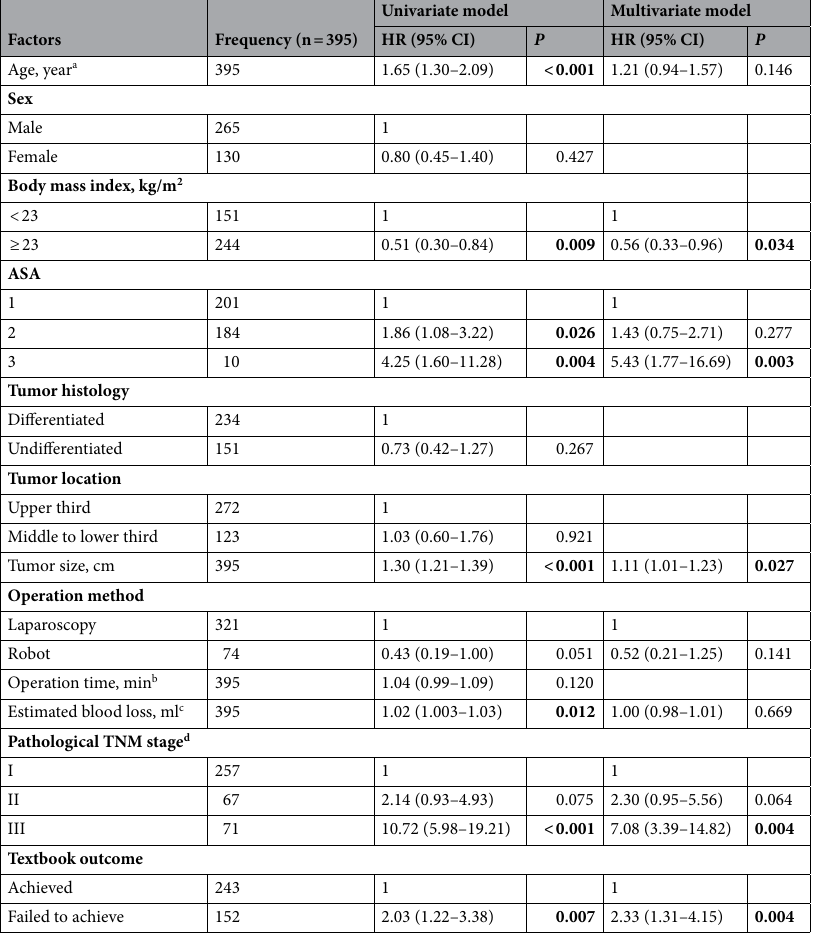
Table 4. Univariate and multivariate Cox regression models for relapse-free survival. Statistically significant values ( P < 0.05) are given in bold. HR hazard ratio, CI confidence interval, ASA American Society of Anaesthesiologists. a The hazard ratio shown is for every 10 year increase in age. b The hazard ratio shown is for every 10 min increase in operation time. c The hazard ratio shown is for every 10 ml increase in estimated blood loss. d Stage, according to the 8th edition of the American Joint Committee on Cancer staging system for gastric